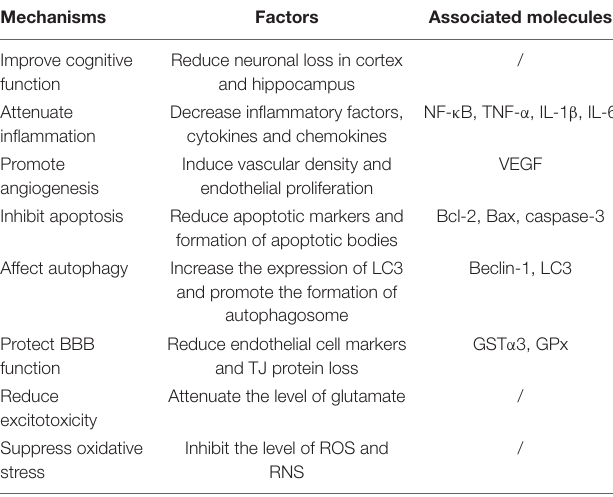
TABLE 3 | Mechanisms of circRNAs in acute CNS